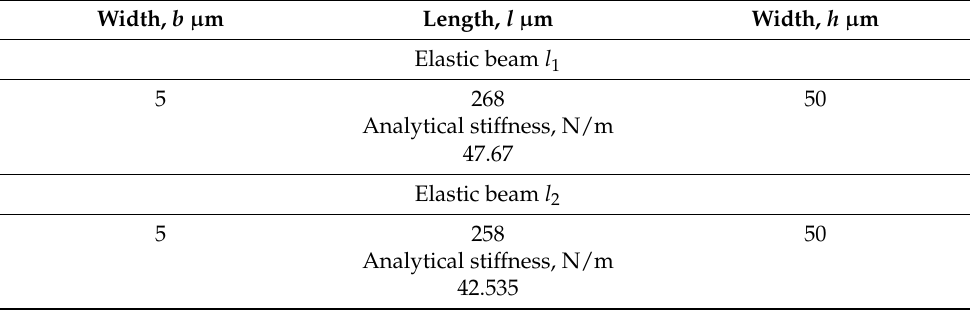
Table 5. Design parameters of the elastic element.